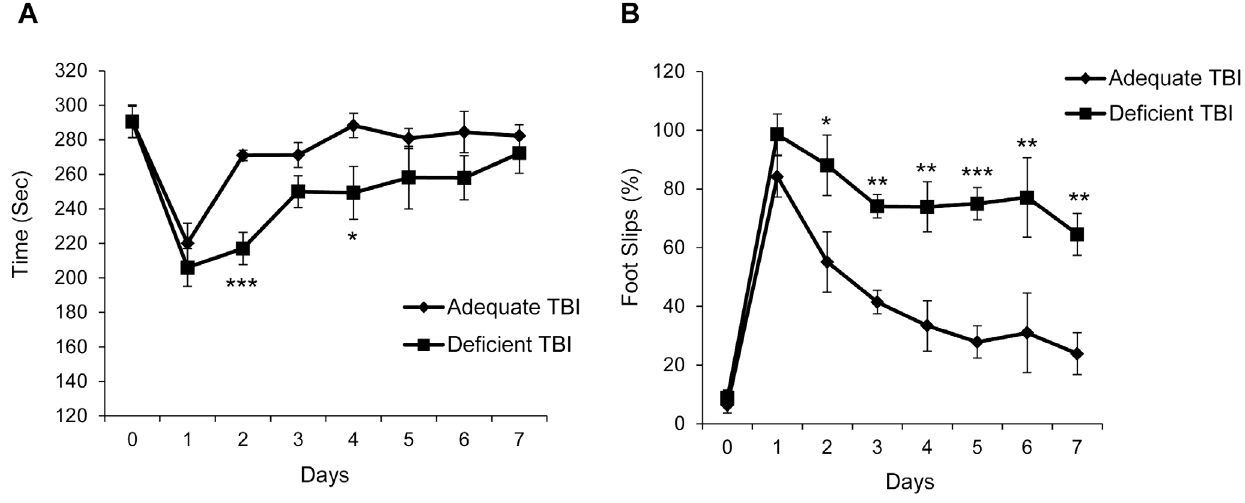
Figure 1. Omega-3 fatty acid deficiency impairs recovery from TBI-induced motor deficits. (A) The rotarod test showing slower recovery from TBI in the DHA deficient group (Deficient TBI) as compared to the adequate (Adequate TBI) mice with statistically significant differences on day 2 and day 4 after TBI (* p , 0.05 and *** p , 0.001 vs. the respective O-3 adequate group; n= 8). (B) The beam walk test showing greater hindlimb footslips in DHA deficient mice as compared to the respective adequate controls (* p , 0.05, ** p , 0.01 and *** p , 0.001 vs. adequate TBI group; n= 7– 8).